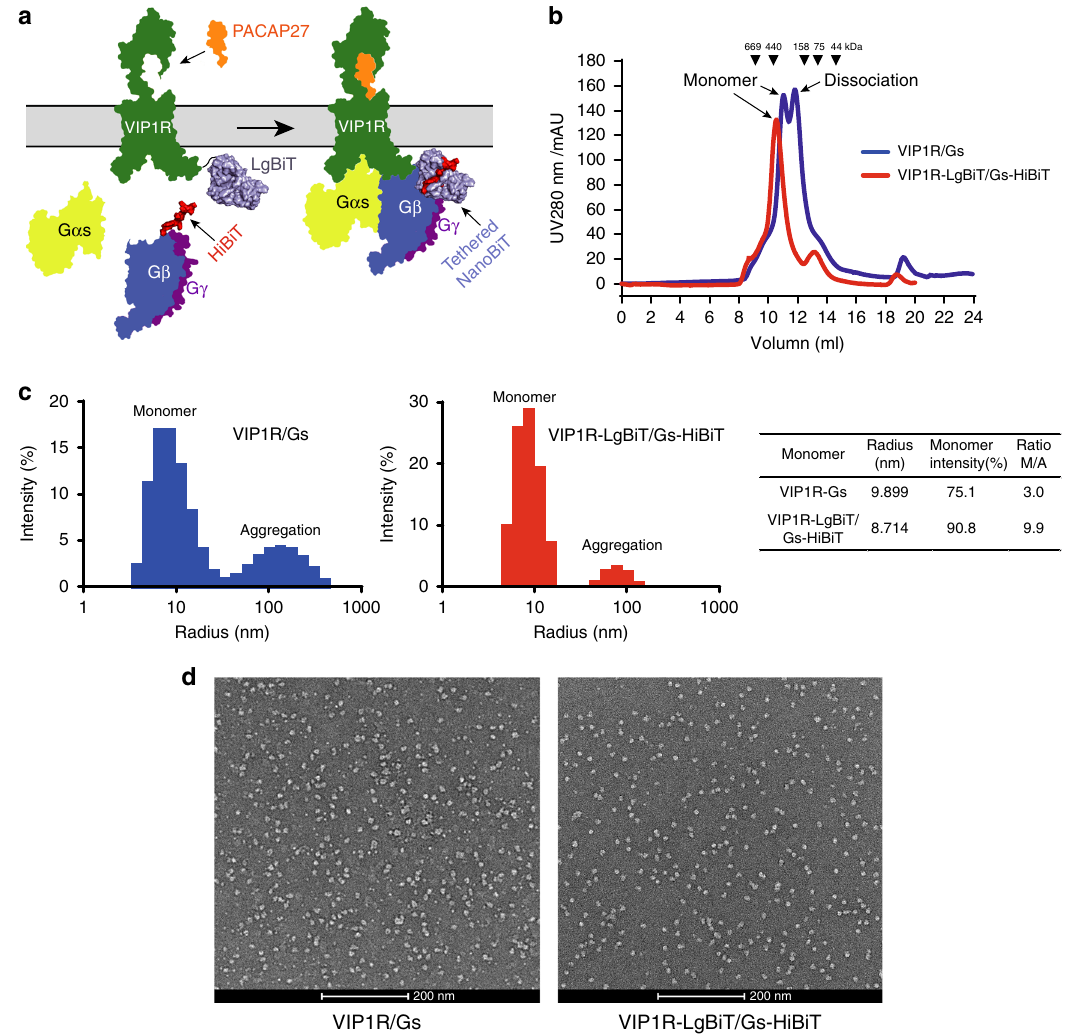
Fig. 1 The NanoBiT strategy for stabilization of PACAP27 – VIP1R – Gs protein complex. a Schematic diagram of the NanoBiT aided assembly of the VIP1R – Gs complex. PACAP27 is colored in orange, VIP1R in green, G α s in yellow, G β in blue, G γ in purple, LgBiT in light blue, and HiBiT in red. b Respective size-exclusion chromatography elution pro fi les of the VIP1R – Gs and VIP1R-LgBiT-Gs-HiBiT complexes. c Dynamic light scattering (DLS) size distribution histograms of VIP1R – Gs and VIP1R-LgBiT-Gs-HiBiT complexes. Values of radius, % intensity of monomer, and ratio of monomer/aggregation (M/A) are listed. d Representative negative staining images of the corresponding complexes. The scale bar is 200 nm. Source data are provided as a Source Data fi